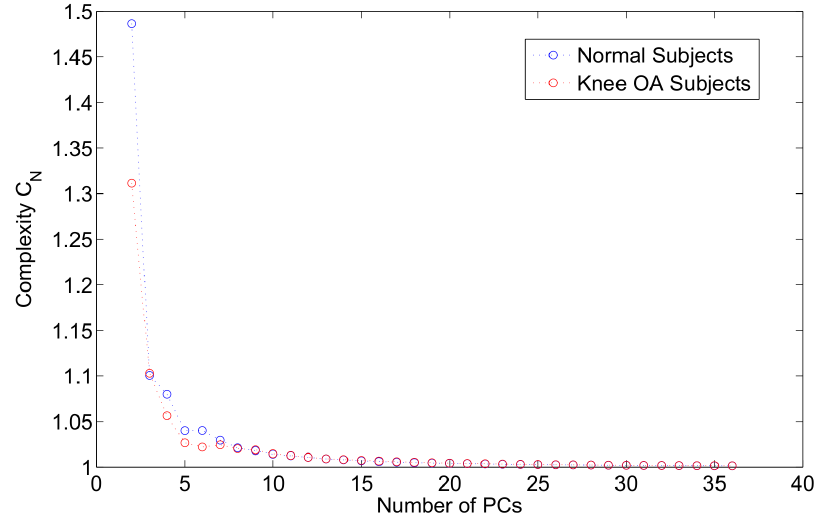
Figure 5. The proposed complexity measure C N for the first 36 PCs. In the lower PC dimensional space knee OA subjects have a tendency to present lower values.